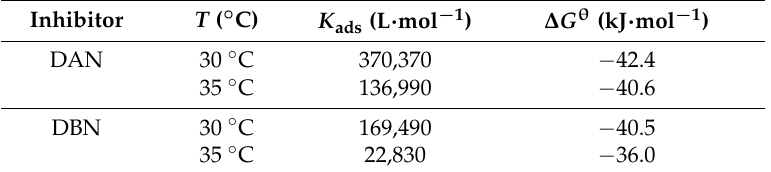
Table 3. Values of K ads and Δ G θ of DAN and DBN adsorbed on AA5052 at 30 °C and 35 °C.